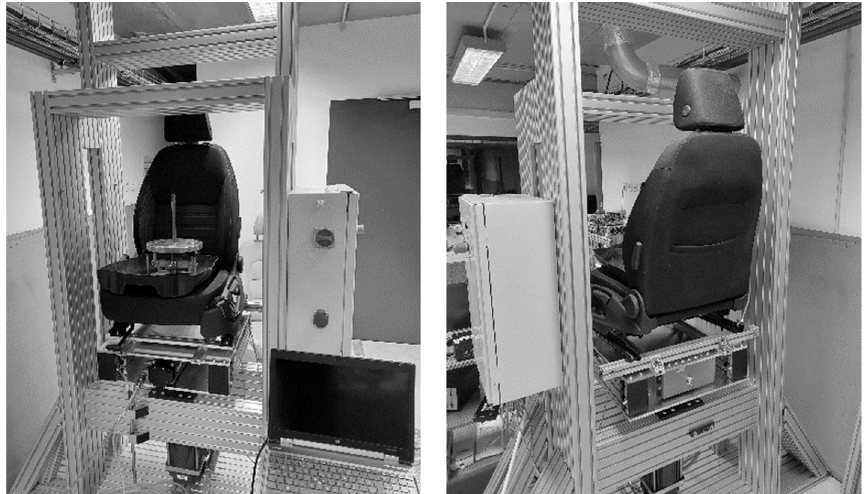
Figure 1. Original test equipment for biaxial loading.